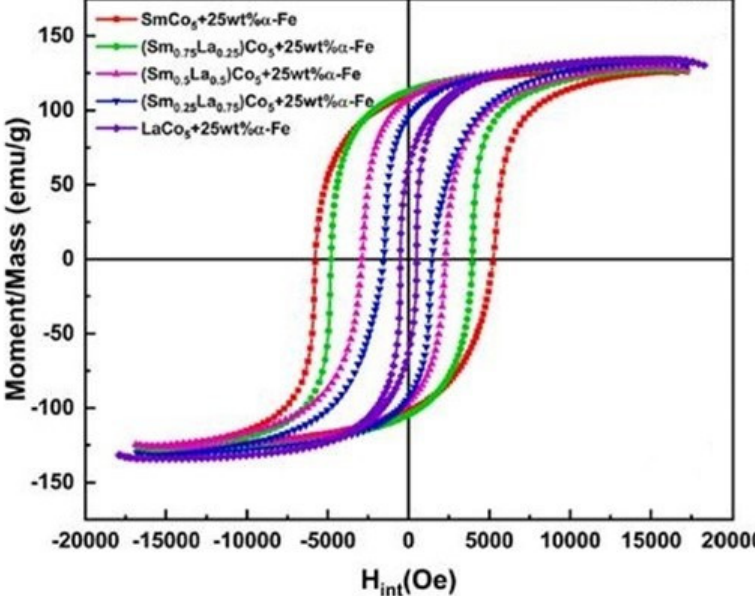
Figure 11. Hysteresis loop of SmCo 5 / α -Fe magnetic nanocomposites [96]. (License obtained to use this Figure from Elsevier Publications, Journal of Magnetism and Magnetic Materials).